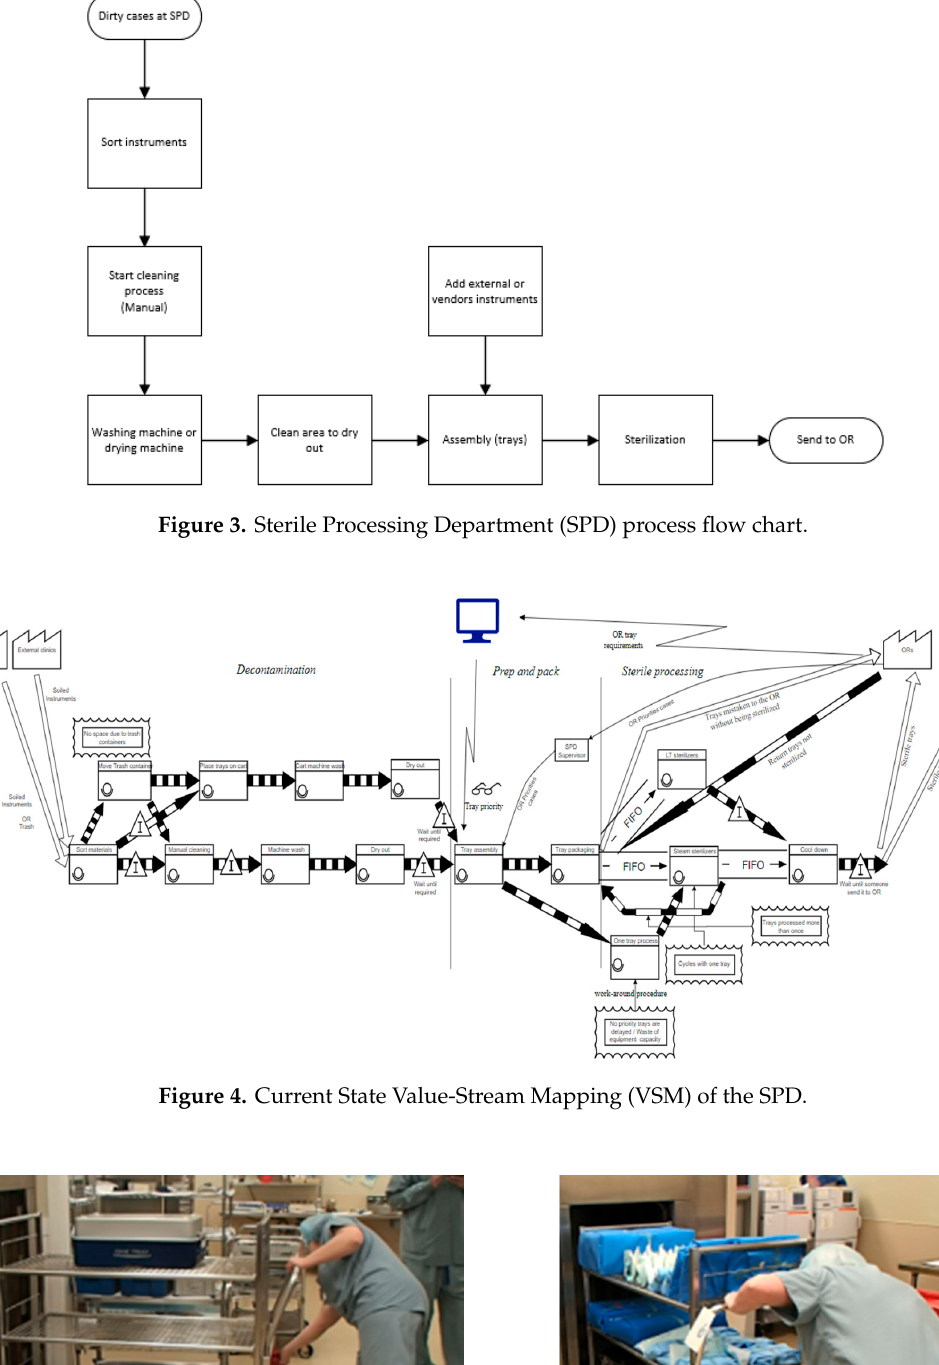
Figure 5. Carts going into the steam sterilizer: ( a ) Cart with one tray, ( b ) Cart at full capacity.